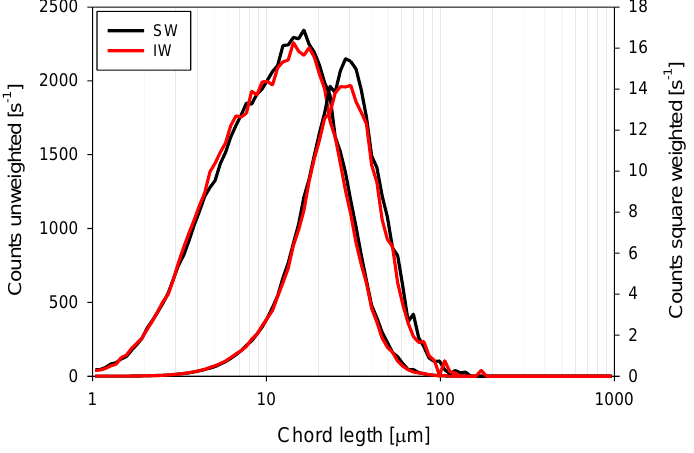
Figure 7. Unweighted and square-weighted chord length distribution from non-flocculated of kaolin suspensions in IW and SW. Solid concentration 5 wt% and pH 7.